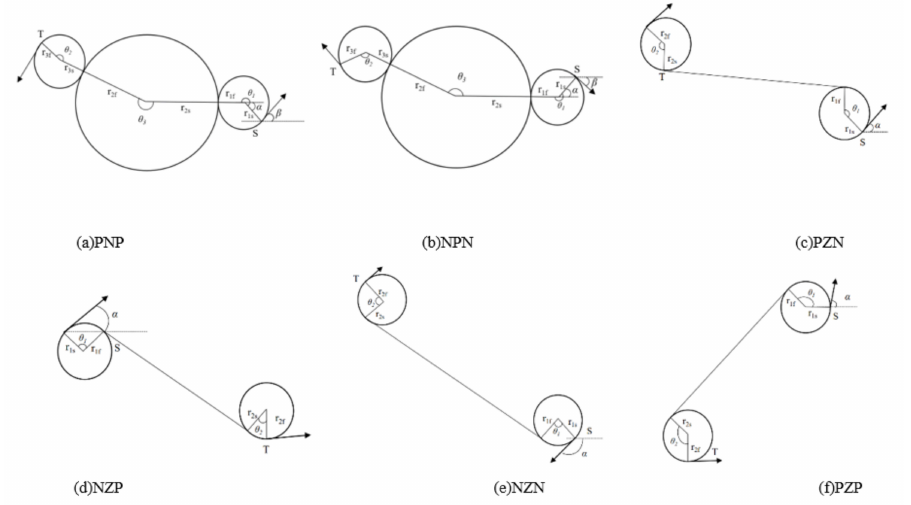
Figure 3. Ship Dubins curve